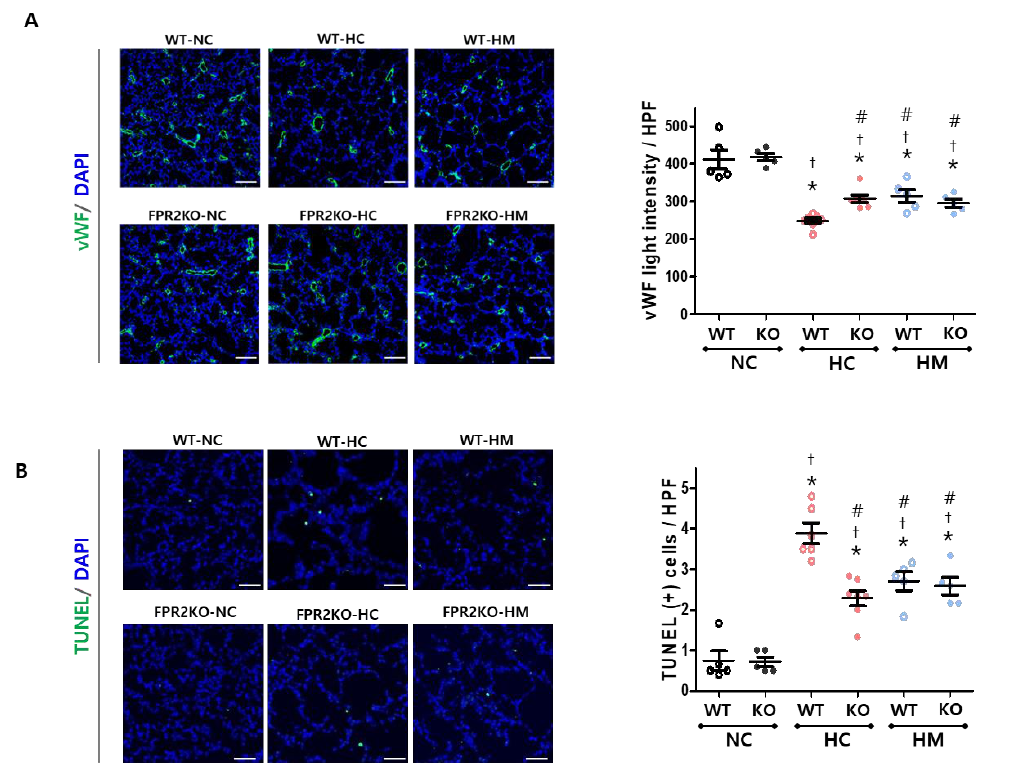
Figure 4. Angiogenesis and cell death in wild − type and FPR2 −/− mice. ( A ) Representative photomicrographs of von Willebrand factor (vWF; green) stained lung sections (scale bar, 100 μm) and its light intensity per high − power field (HPF). ( B ) Representative photomicrographs of terminal deoxynucleotidyl transferase dUTP nick end labelling (TUNEL; green) stained lung sections (scale bar, 50 μm) and its quantitative bar graphs. Nuclei were counter− stained with 4′ ,6 − diamidino − 2 − phenylindole (DAPI; blue). Data are given as mean ± SEM. * p < 0.05 vs. NC in WT. † p < 0.05 vs. NC in KO. # p < 0.05 vs. HC in WT. WT, wild − type mouse; KO, FPR2 −/− mouse; NC, normoxia control; HC, hyperoxia control; HM, hyperoxia with intratracheal transplantation of human umbilical